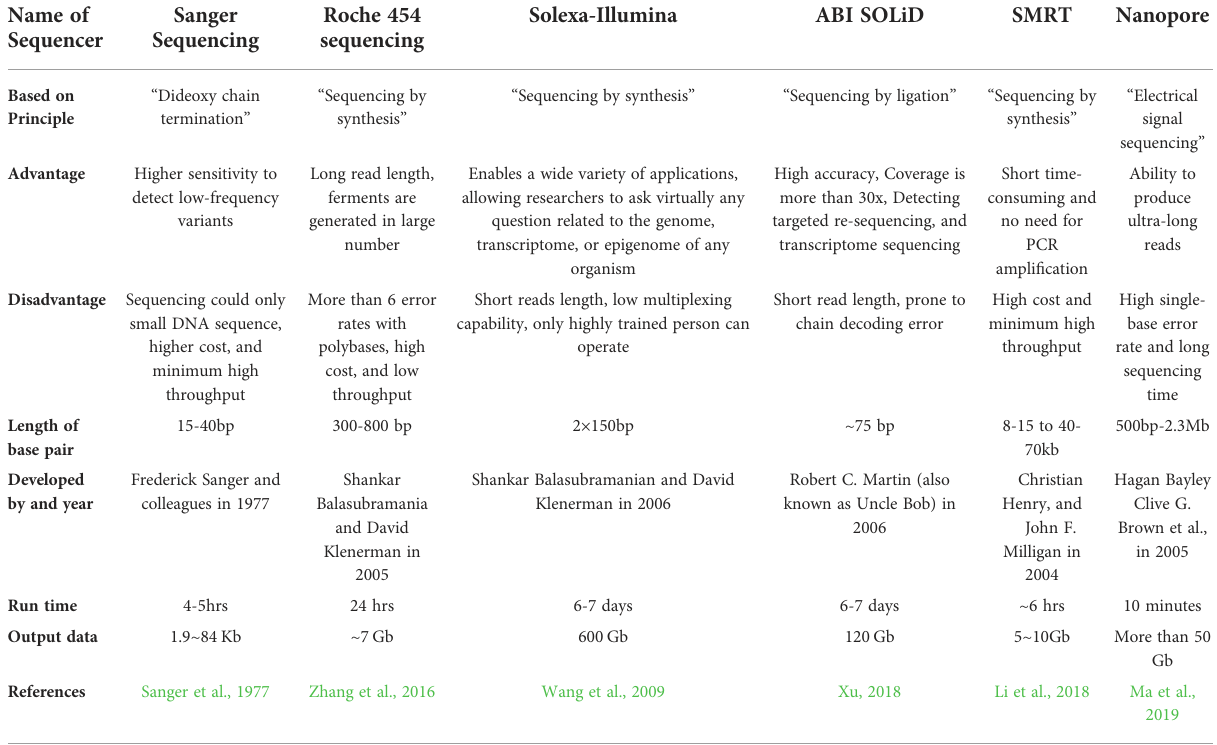
TABLE 1 Comprehensive overview of various next-generation sequencing (NGS)